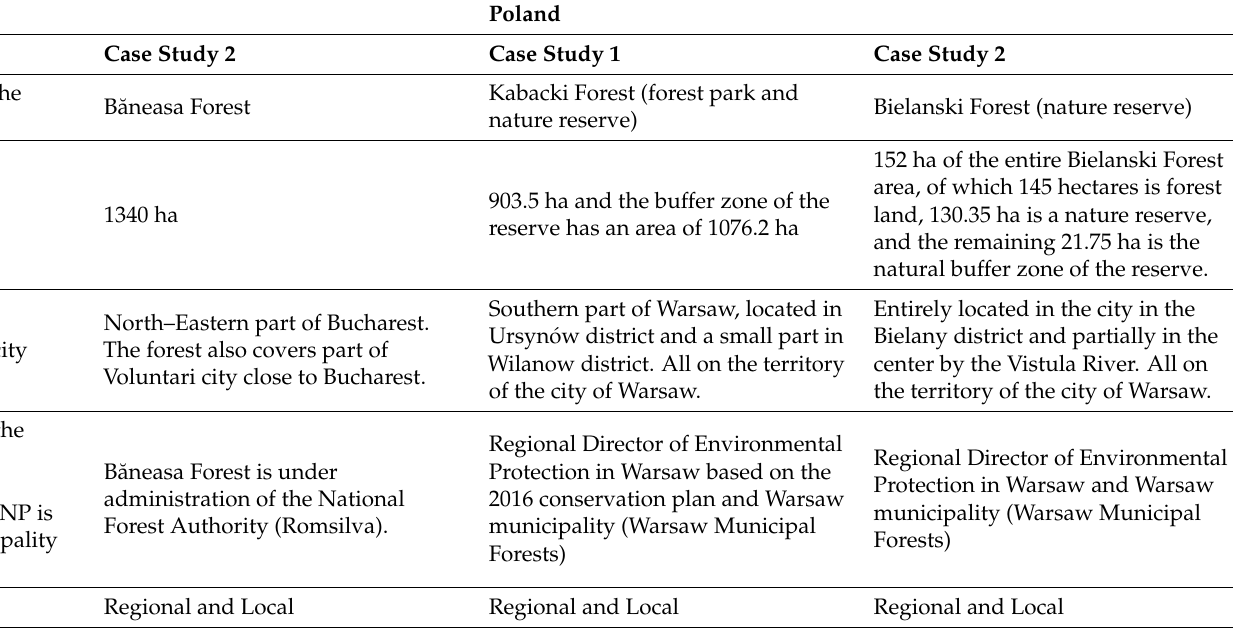
Table 3. Case studies from Romania and Poland—a comparative overview. For additional details, please see the detailed presentations following the